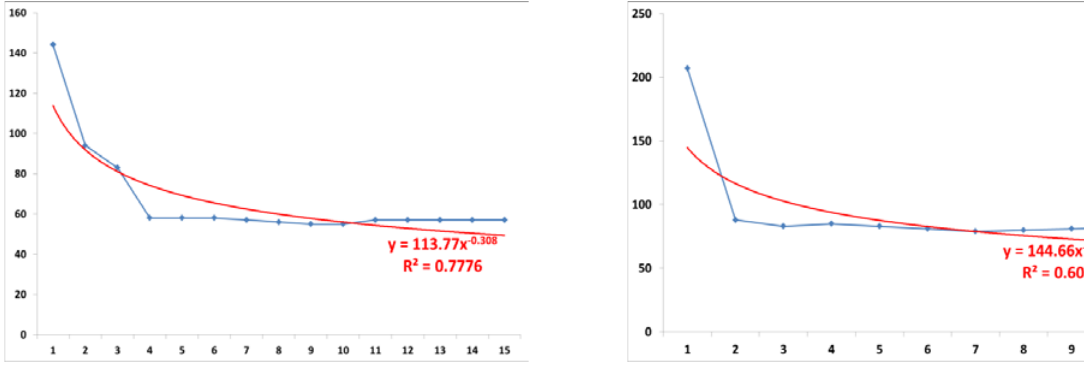
Fig. 16. Power Graph for Backward-Forward Approach (examples 12 and